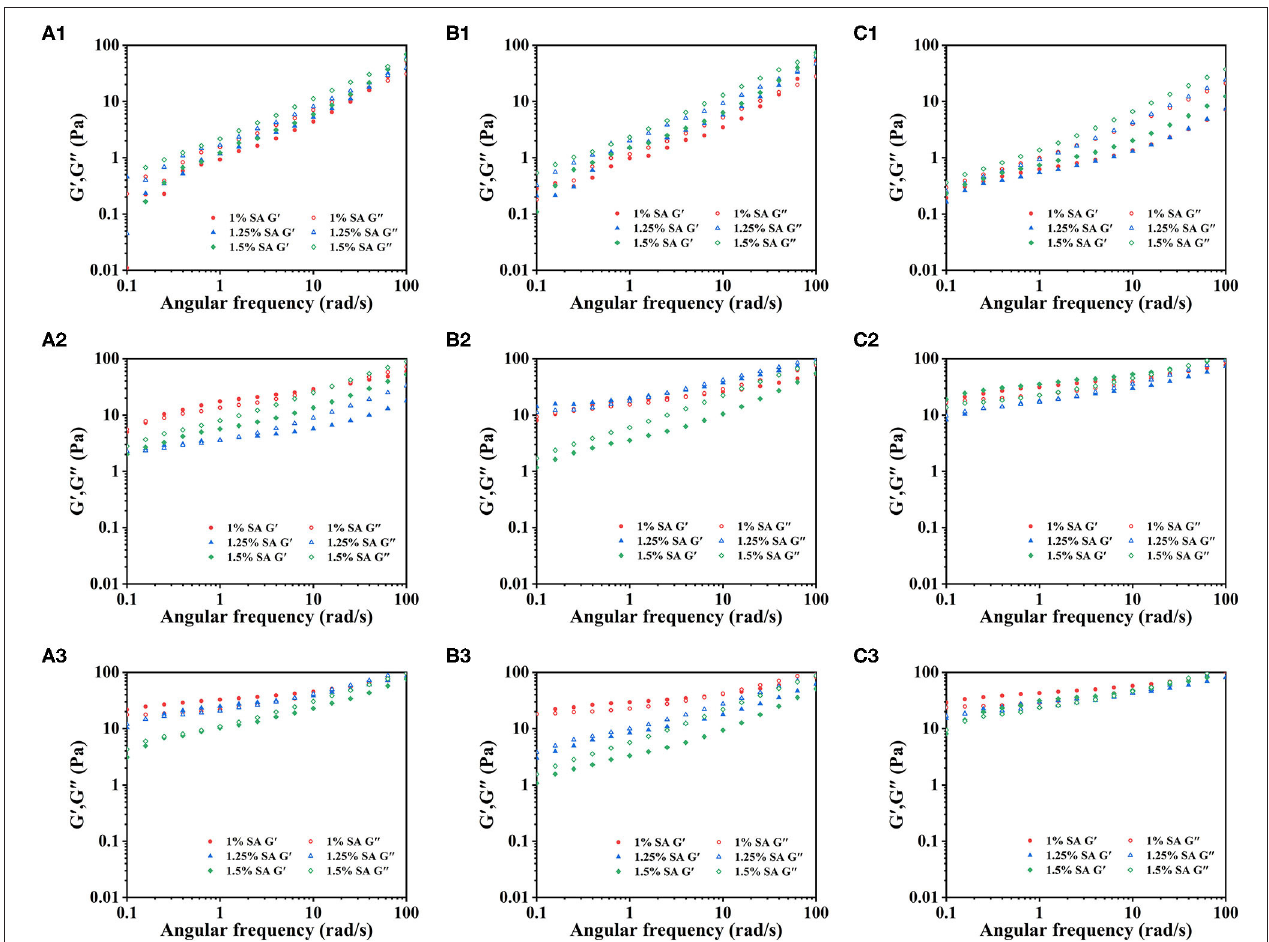
FIGURE 4 | Dynamic frequency sweep images: E1 emulsions stored for 0 (A1) , 14 (A2) , and 28 (A3) days; E2 emulsions stored for 0 (B1) , 14 (B2) , and 28 (B3) days; E3 emulsions stored for 0 (C1) , 14 (C2) , and 28 (C3) days.